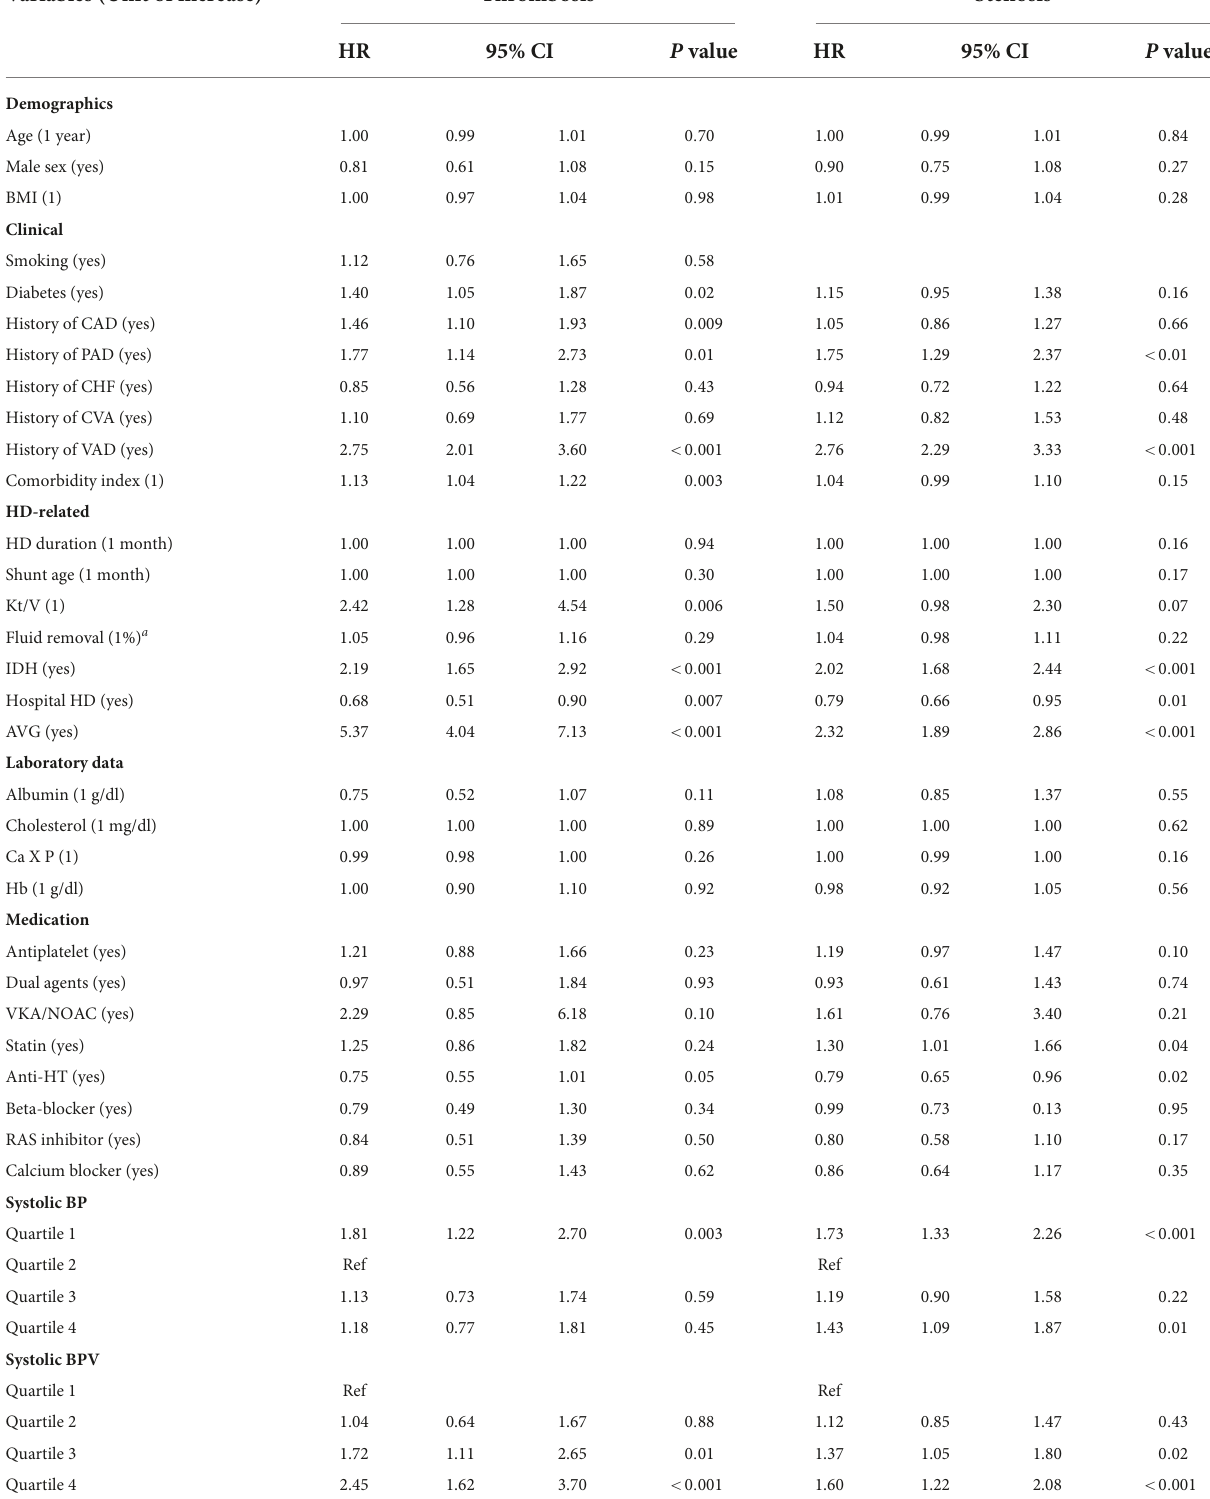
TABLE 3 Univariate Cox regression analysis of predictors for incident vascular access thrombosis or stenosis during follow-up period. Variables (Unit of increase) Thrombosis